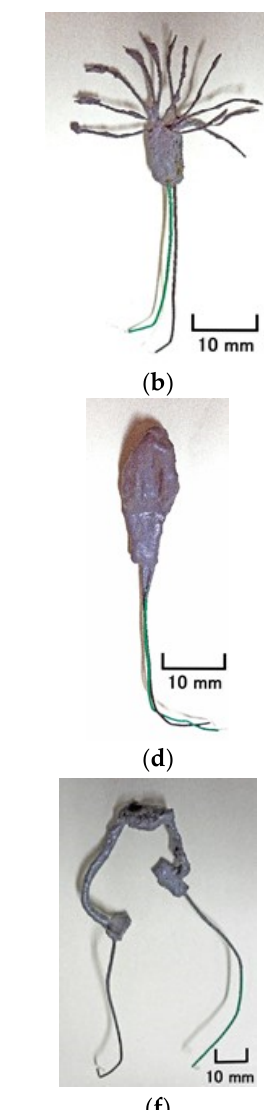
Figure 10. Consummated fabric of each cutaneous receptor mimicking human skin: ( a ) Type-A HF sensor for free nerve endings; ( b ) Type-B HF sensor for Krause and bulbs; ( c ) Type-C HF sensor for Meissner corpuscles; ( d ) Type-D HF sensor for Pacinian corpuscles; ( e ) Type-E HF sensor for Ruffini endings.